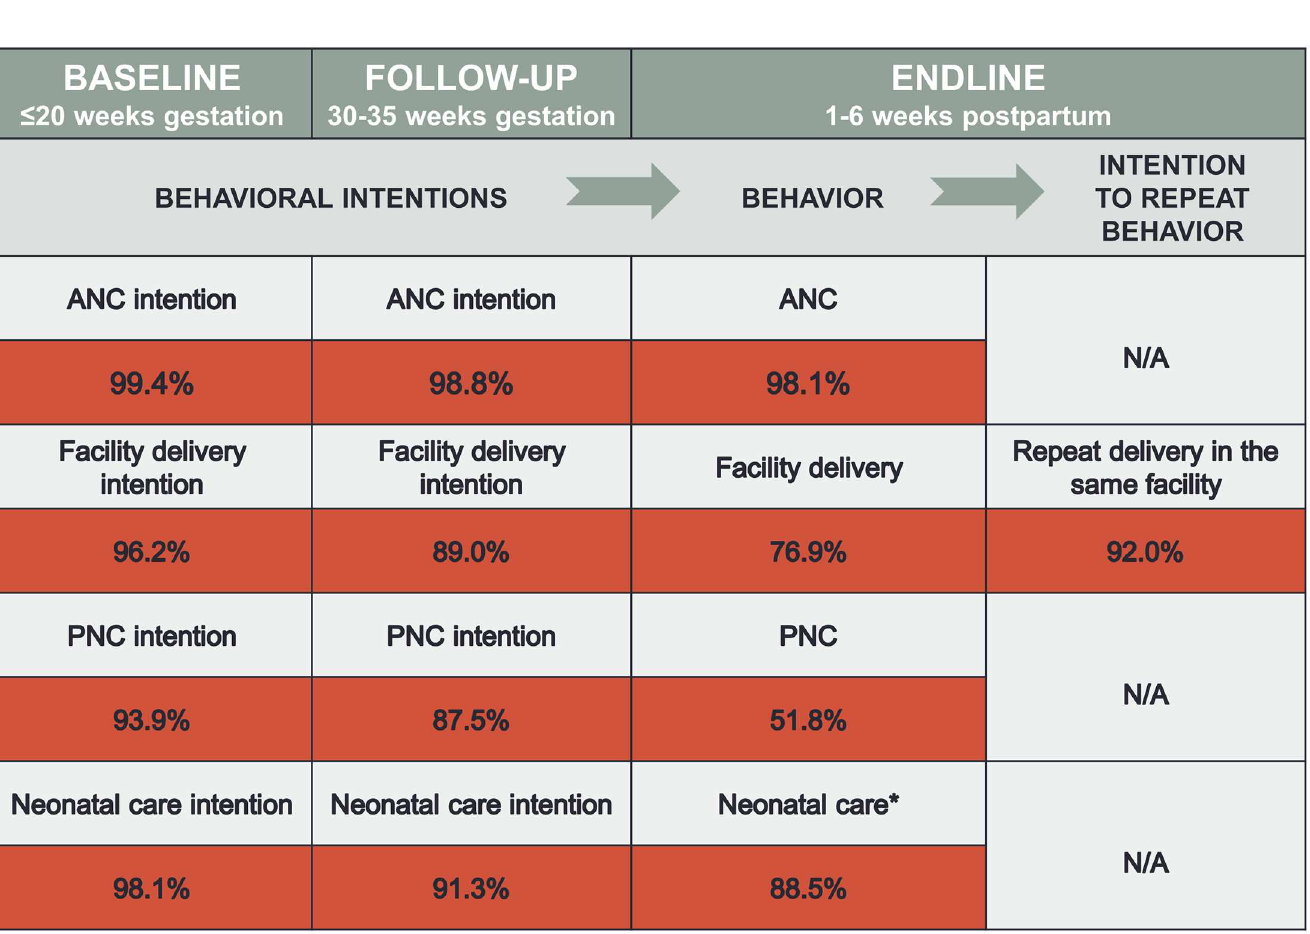
PLOS ONE | DOI:10.1371/journal.pone.0162017 September13,